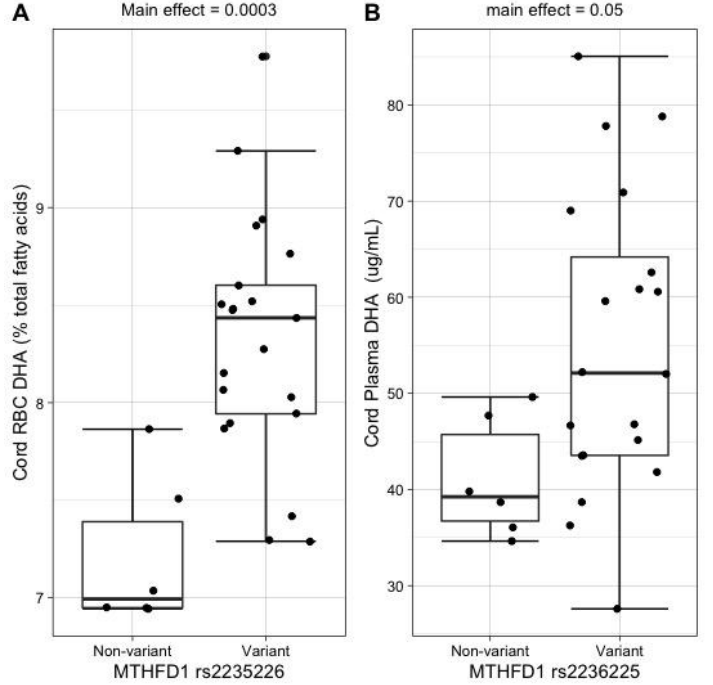
Figure 4. Relationship between maternal MTHFD1 rs2235226 genotype and cord DHA status indica- tors ( A ) Cord RBC-DHA (% total fatty acids; raw data boxplot). ( B ) Cord plasma DHA ( µ g/mL; raw data